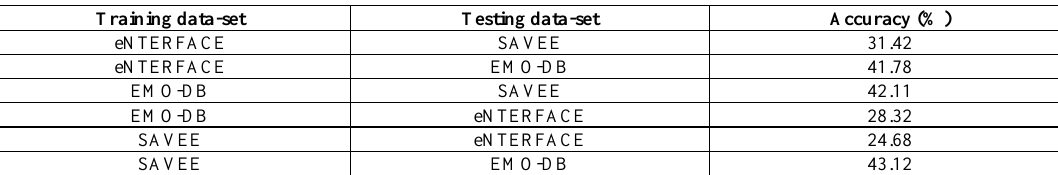
Table 4. AER performance for cross data-sets.